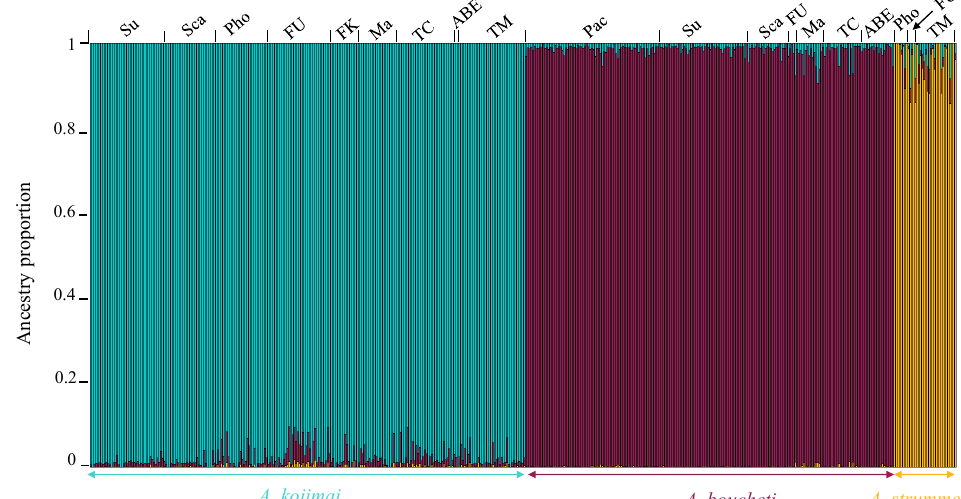
Figure 7. Ancestry coefficients bar plots representing K = 3 for the three species of Alviniconcha sampled during the Chubacarc expedition. This graphic was obtained using the snmf function in the package LEA (R software [55]) on 60,084 SNPs for 498 individuals with 20 runs. Each vertical bar corresponds to one individual. The colours (purple: A. boucheti , turquoise: A. kojimai , and yellow: A. strummeri ) were assigned according to the ancestry inferred for each cluster. Manus Basin: Susu (Su); Pacmanus (Pac). Woodlark Basin: Scala (Sca). North Fiji Basin: Phoenix (Pho). Futuna volcanic Arc: Fatu-Kapa (FK); Fati-Ufu (FU). Lau Basin: Mangatolo (Ma); Tow Cam (TC); ABE (ABE); Tui Malila